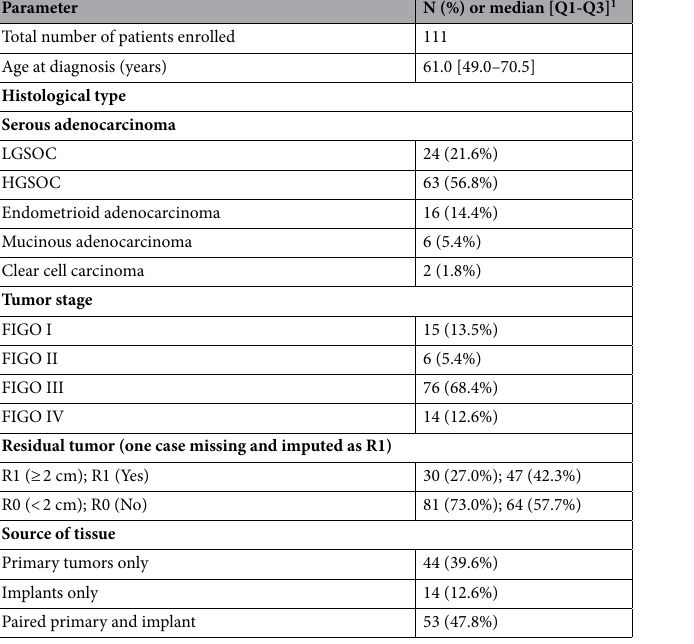
Table 1. Patients’ characteristics. 1 Q1, 25th and Q3, 75th